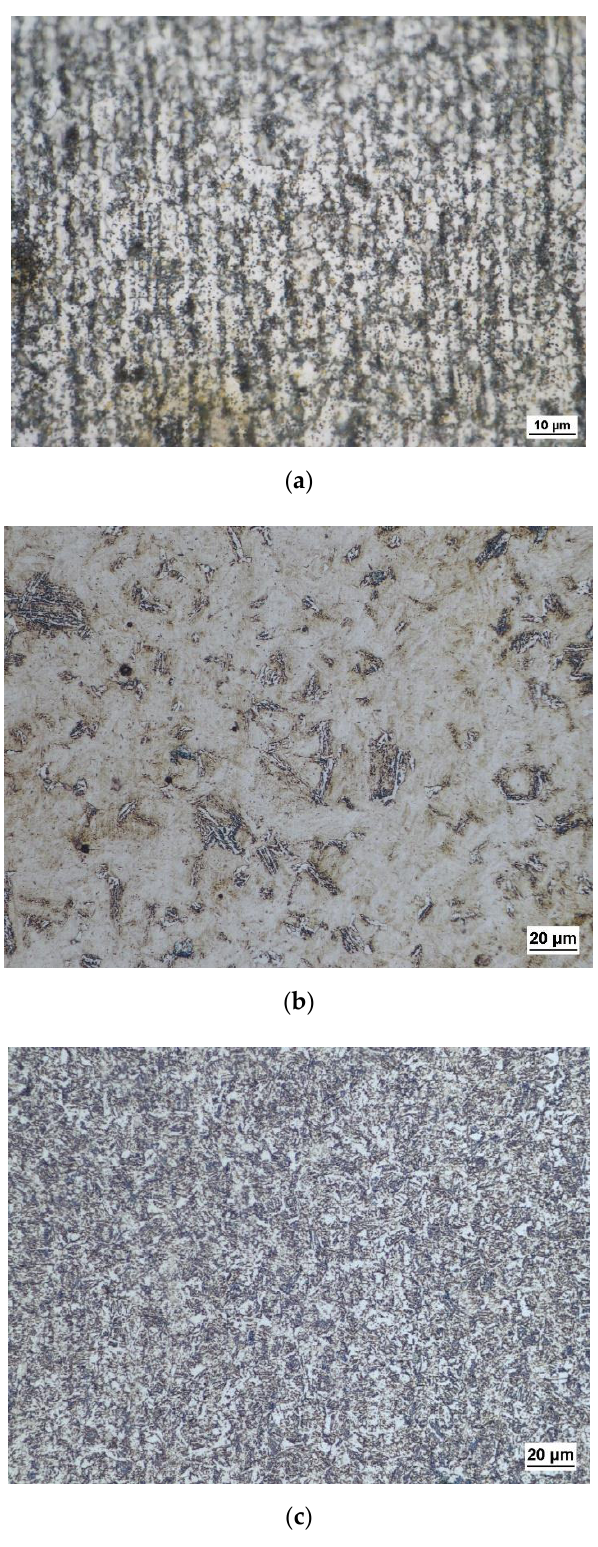
Figure 14. ( a ) Microstructure of USIBOR ® 2000 steel in the supply state (1000 × ). ( b ) Microstructure of the USIBOR ® 2000 steel obtained in the specimen central point with the T500tq20 condition (1000 × ). ( c ) Microstructure of the USIBOR ® 2000 steel obtained in the specimen central point with the T500tq250 condition (1000 ×